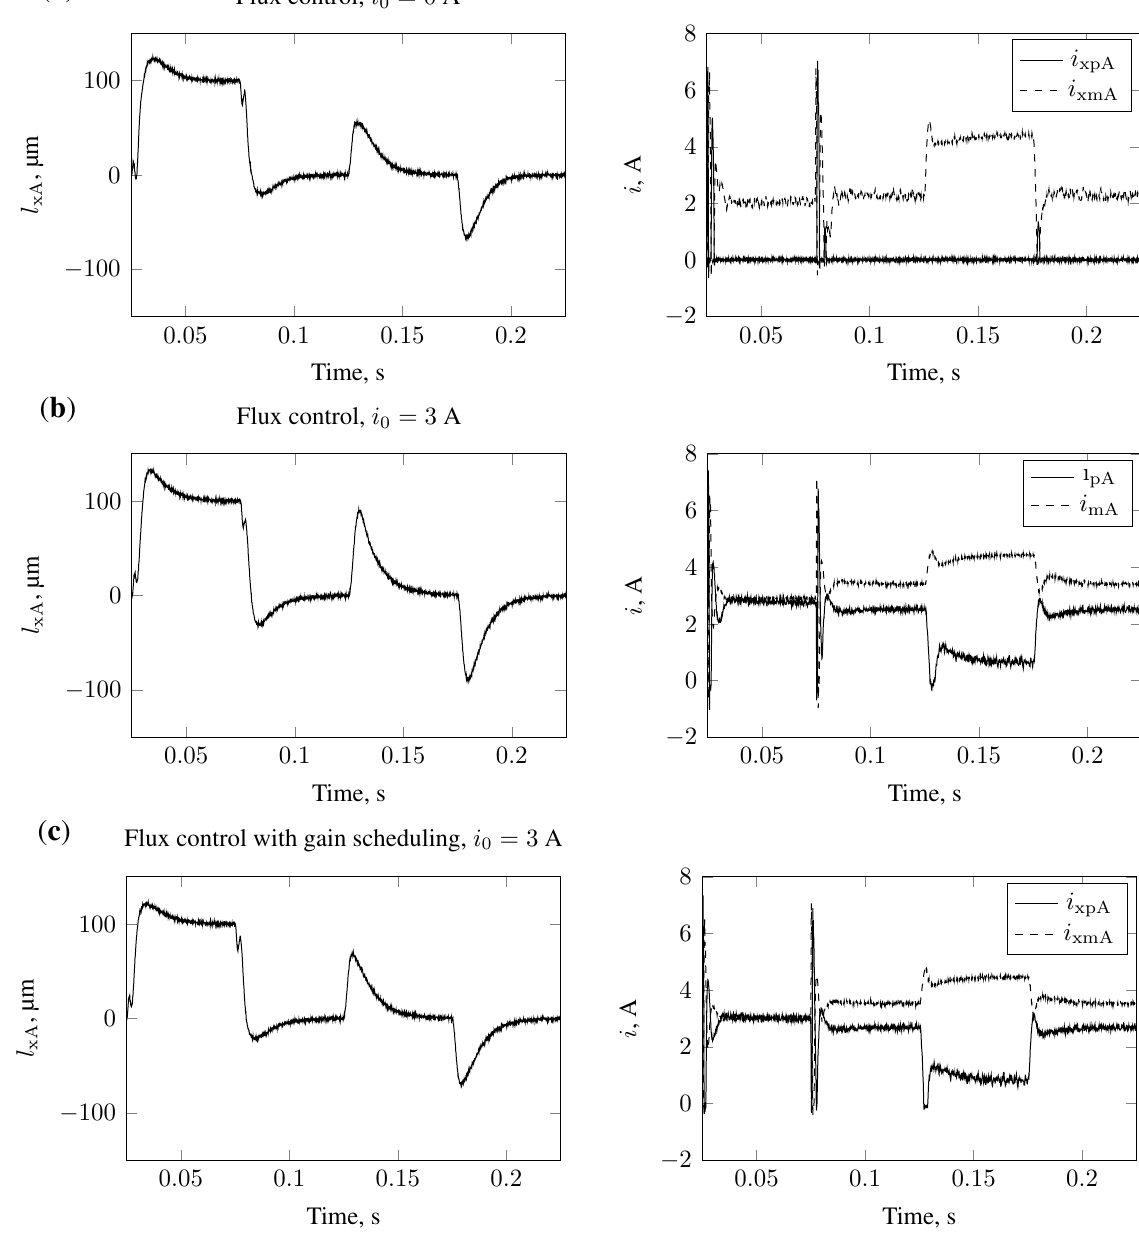
Figure 4. Simulated step position reference and disturbance force responses of the selected position and current signals of the centralized radial AMB rotor system. i are the coil currents resulting in the magnetic force generation that acts in the positive and negative direction of the x -axis at the A-end of the rotor. ( a ) Flux controlled system with zero bias; ( b ) Flux controlled system with bias; ( c ) Flux controlled system with bias and gain scheduling in the inner control